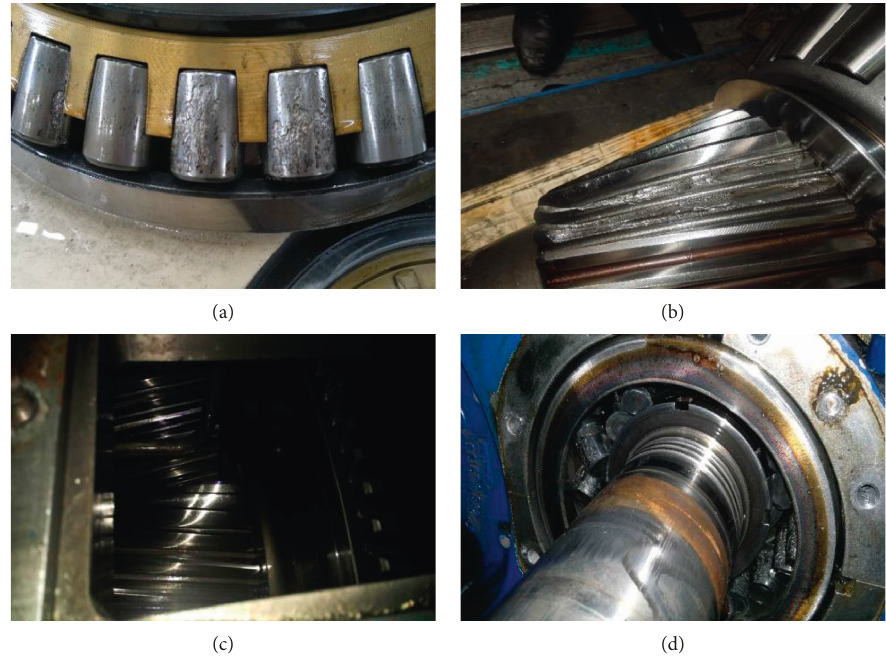
Figure 3: Worn tooth (a), tooth fracture (b), tooth surface deformation (c), and bearing faults (d) of the wind turbine gearbox.